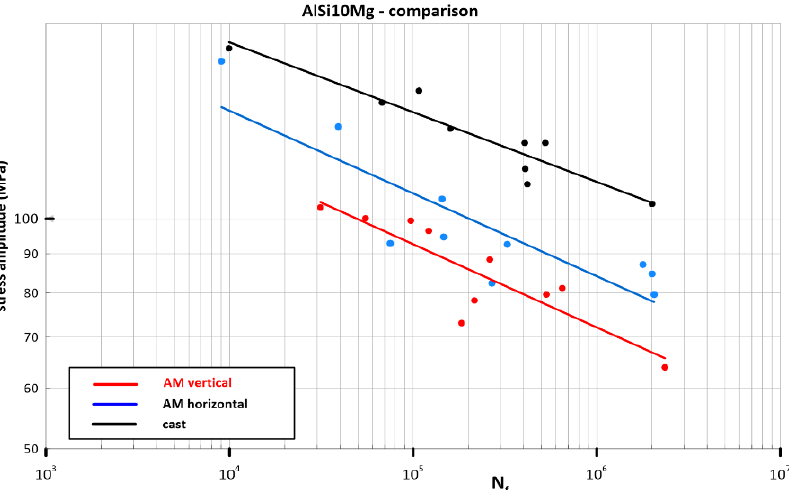
Figure 8. Comparison of AlSi 10 Mg S-N curves of material produced by di ff erent technological pro-